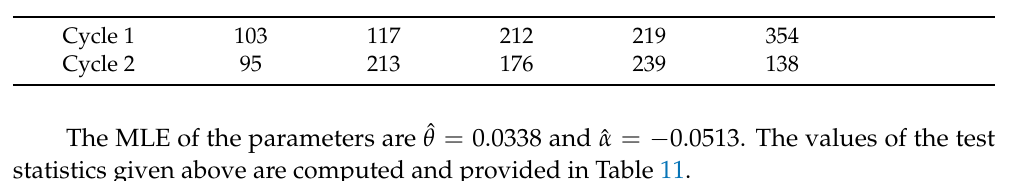
Figure 6. The TTT, box, and density plots of the WGQLD for the rain data. We extracted a ranked set sample of size N = 10 using a set size k = 5 and n = 2 from the data assuming that the ranking is perfect and applied the different GFT considered in this study. The sampled values based on RSS are shown in Table 10. Table 10. The sample values using RSS.